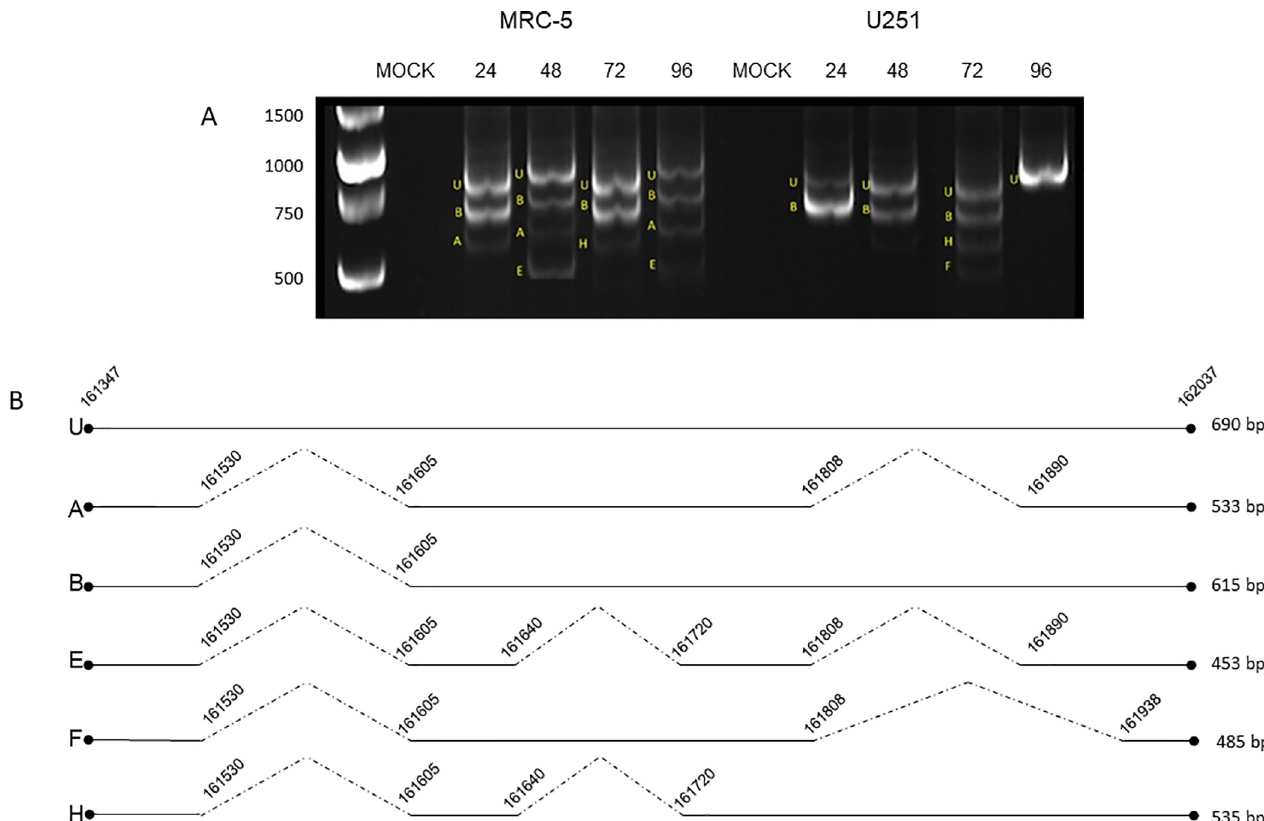
Fig 1. HCMV IL-10 transcripts detected in infected cells. (A) Acrylamide gel electrophoresis showing the HCMV IL-10 transcripts obtained by nested PCR, in MRC-5 and U251 cells, infected for the time points indicated. The identitity of the transcripts determined by DNA sequencing is indicated by the letters (U) unspliced; (A) transcript A (cmvIL-10); (B) transcript B (LAcmvIL-10); transcript E, F and H. (B) Squematic illustration of HCMV IL-10 pre-mRNA (unspliced) and the transcripts identified. Exon (continuous lines) and intron (dotted lines) positions are shown according to the HCMV TB40e strain (gene Bank: KF297339). The start and end positions of each intron are numbered, relative to the TB40E